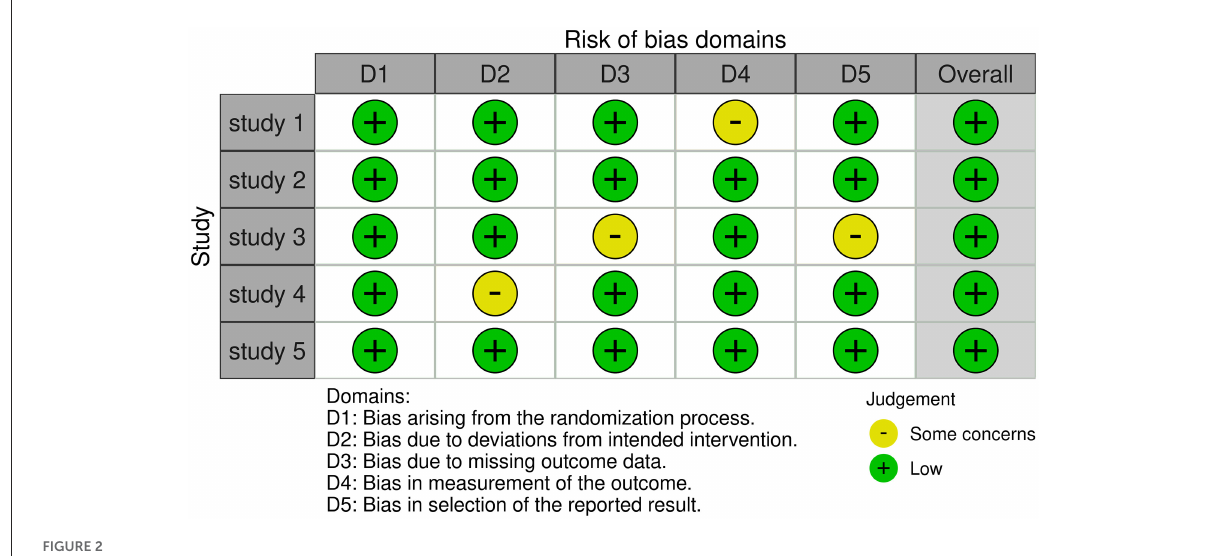
FIGURE2 Quality assessment of included